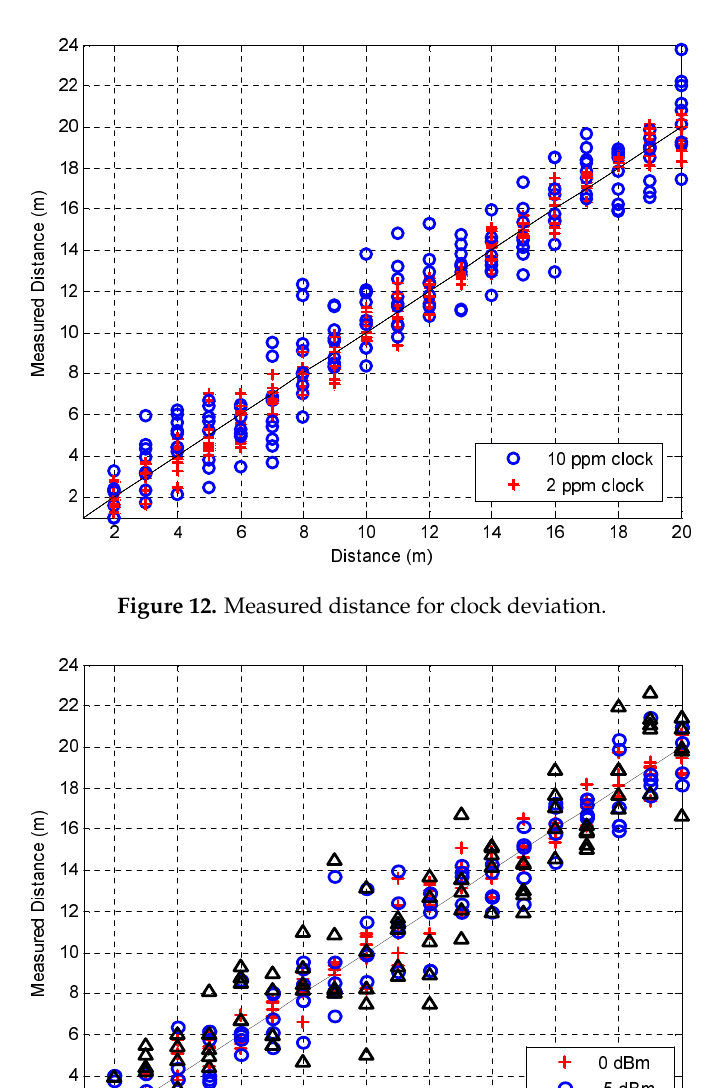
Figure 11. Evaluation environment in indoor experiments.